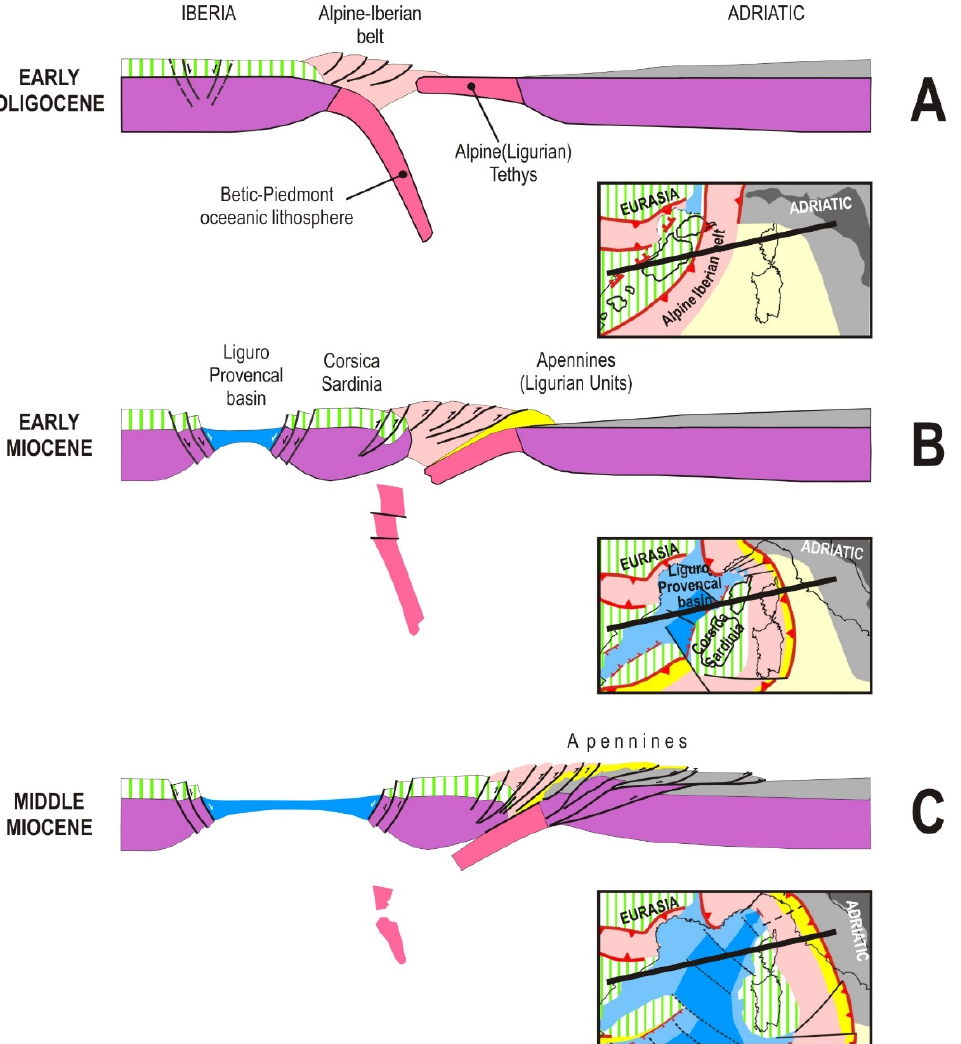
Figure 6. Tentative reconstruction, of the main tectonic processes that developed since the Oligocene along an East–West section crossing the Western Mediterranean region: ( A ) The old oceanic litho- sphere which lay along the eastern side of Iberia is completely consumed and the Alpine–Iberian accretionary belt is formed. Crustal sinistral transtension, induced by the push of Nubia on the Alpine-Iberian belt affects the eastern margin of Iberia (see Figure 3). ( B ) Due to belt-parallel compres- sion the Arc (Corsica-Sardinia-Balearic Promontory fragment and the Alpine–Iberian belt) undergoes an eastward displacemet/bending, at the expense of the eastern Alpine Tethys. In the wake of the migrating Arc, crustal extension forms the Northern Balearic (Liguro–Provencal) basin, whereas the old eastward dipping slab is undergoing progressive disruption. Accretionary activity along the outer front of the migrating Arc led to the formation of the Apennine belt. ( C ) The stop of the Arc against the continental Adriatic domain causes the end of crustal extension in the Liguro–Provencal basin.